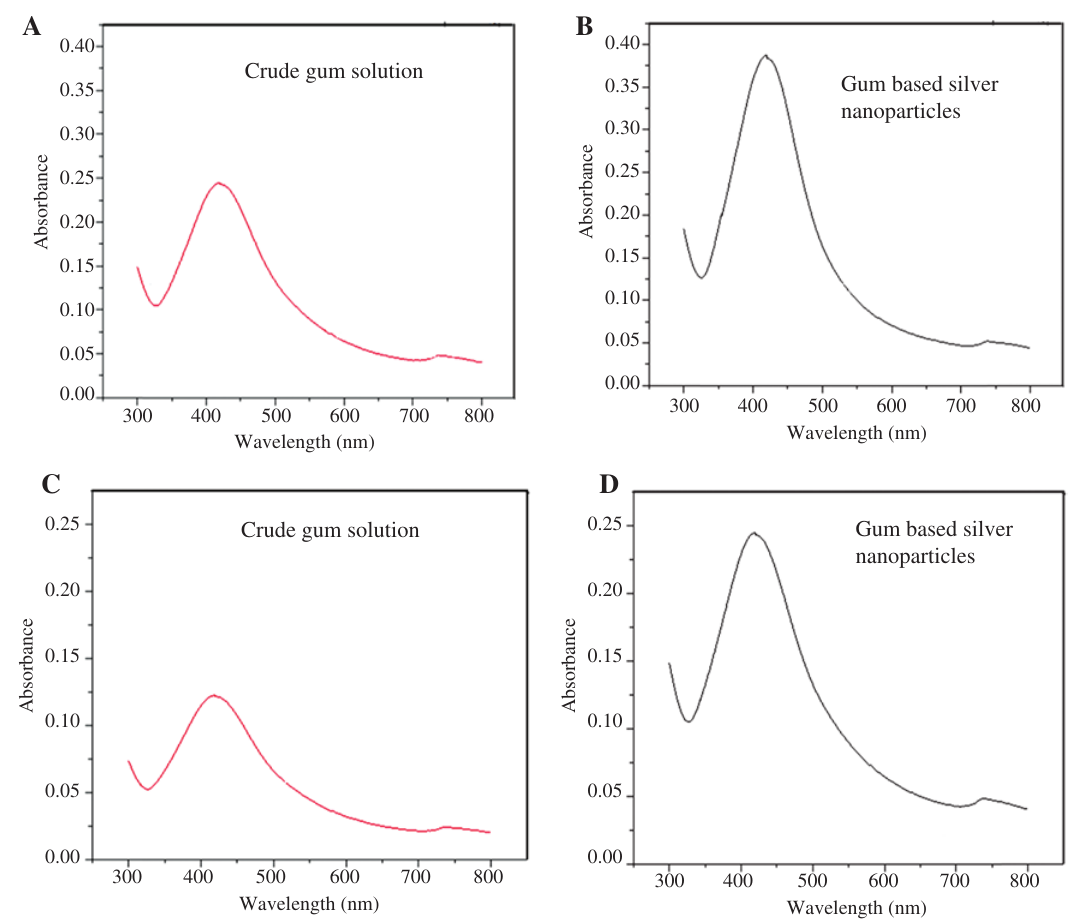
Figure 2: UV-visible spectra of crude and AgNPs using A. modesta (A and B) and D. sissoo (C and D) gums as green matrix.